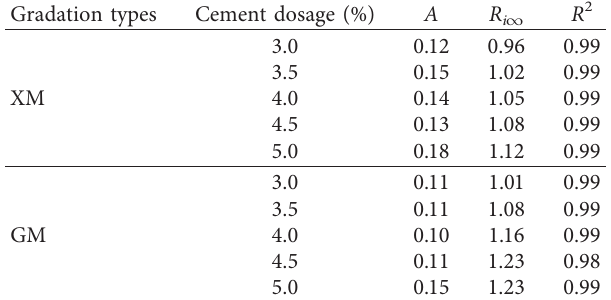
Table 7: Parameters of growth equation of splitting strength of CSCG.